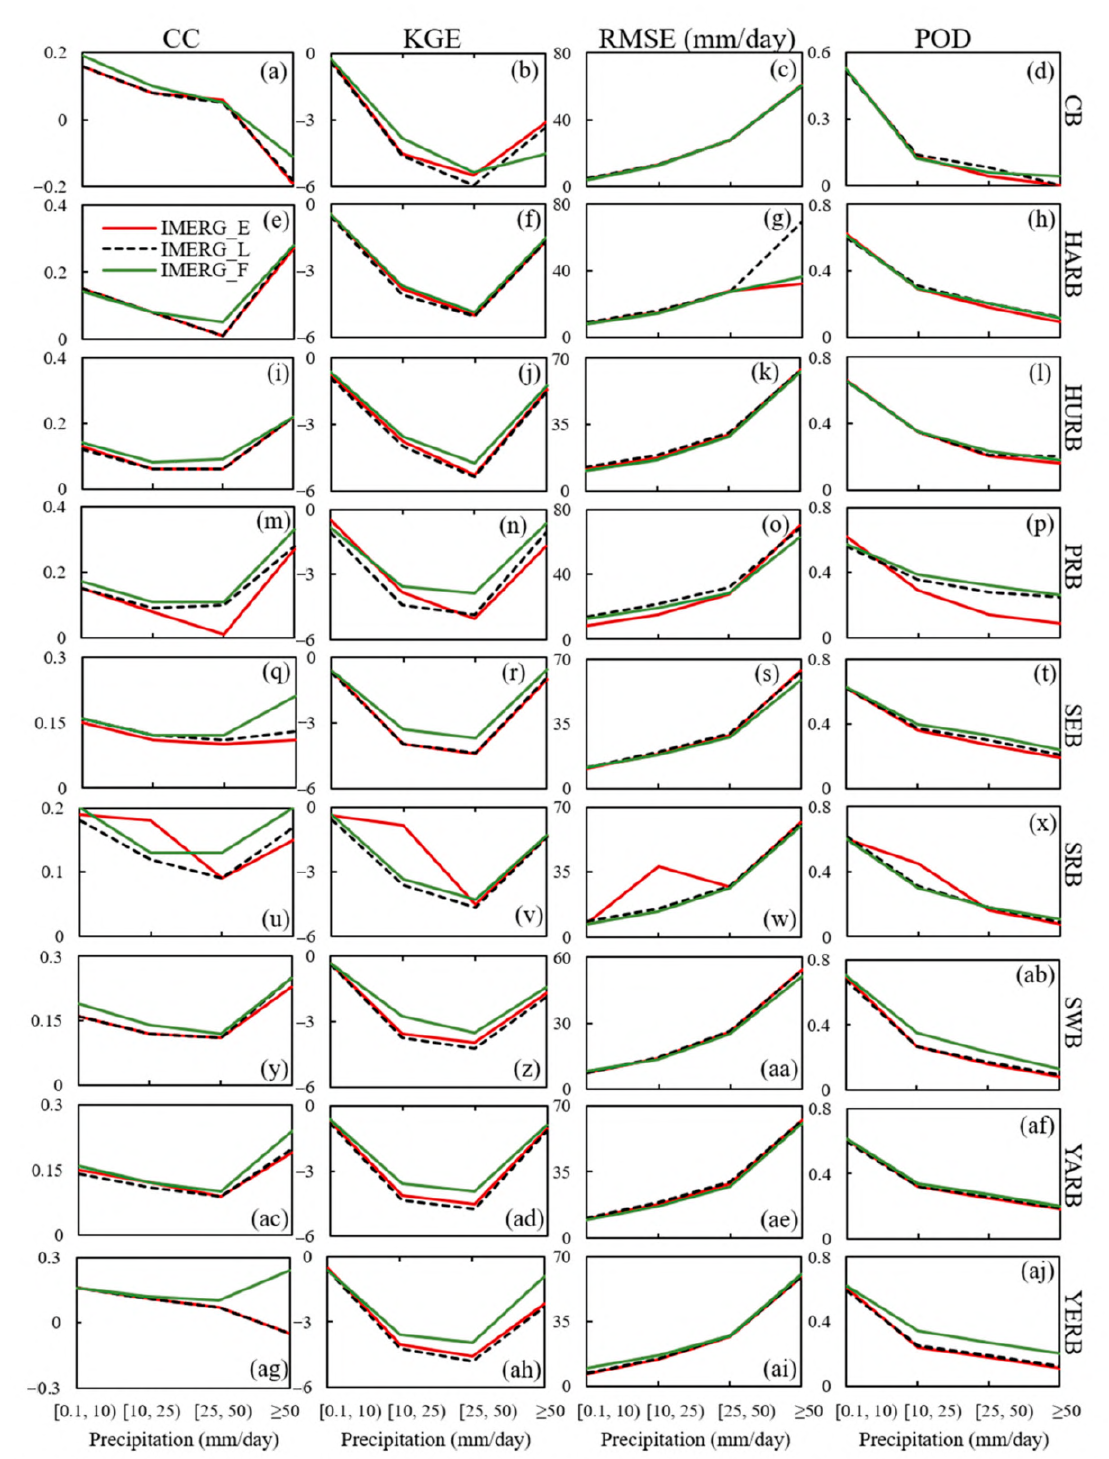
Figure 9. CC ( a , e , i , m , q , u , y , ac , ag ), KGE ( b , f , j , n , r , v , z , ad , ah ), RMSE ( c , g , k , o , s , w , aa , ae , ai ) and POD ( d , h , l , p , t , x , ab , af , aj ) from IMERG_E (red line), IMERG_L (dashed line) and IMERG_F (green line) products in different precipitation intensity across nine basins (CB, Continental Basin; HARB, Haihe River Basin; HURB, Huaihe River Basin; PRB, Pearl River Basin; SEB, Southwest Basin; SRB, Songliao River Basin; SWB, Southwest Basin; YARB, Yangtze River Basin; YERB, Yellow River Basin) during 2008 to